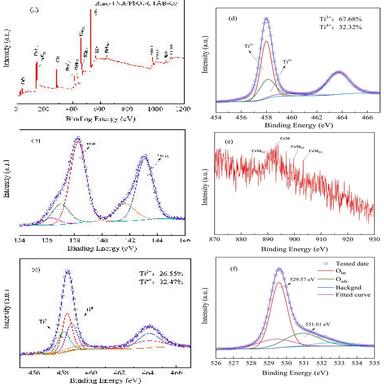
(a) XPS spectra of Blue-TiO2/PbO2-Ce-CTAB electrode; (b) XPS spectra of Pb 4f; (c)XPS spectra of Ti3+/Ti4+ of TiO2-NTs electrode; (d) XPS spectra of Ti3+/ Ti4+ of Blue-TiO2-NTs electrode; (e) XPS spectra of Ce 3d; (f) XPS spectra of O1s. (For interpretation of the references to color in this figure legend, the reader is referred to the web version of this article.)